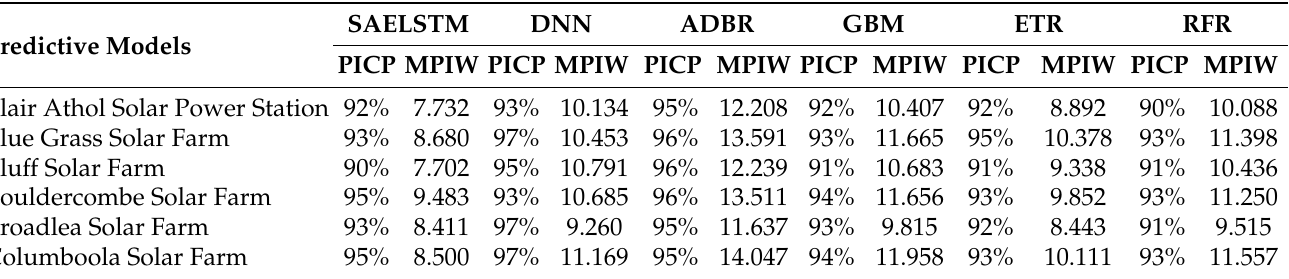
Table 10. The prediction interval quality metrics on six benchmarking models (best result in bold). The best model was assessed with high prediction interval coverage probability (PICP) and low mean prediction interval width